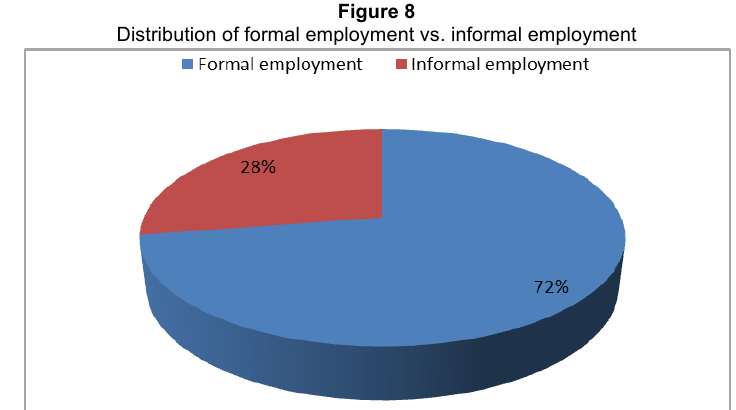
Figure 9 Distribution of level of